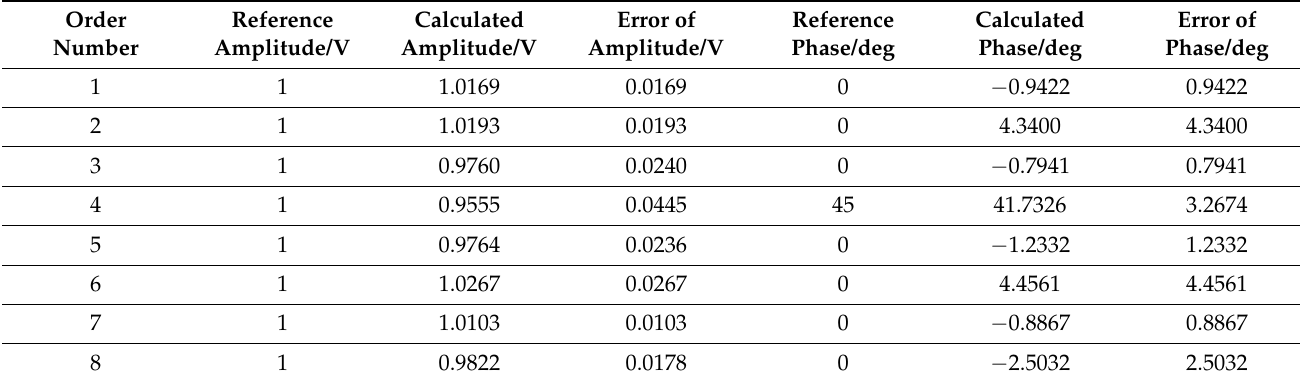
Figure 10. S parameter of Vivaldi linear array. In the event that the phase shifter of unit 4 of the phased array antenna fails. Set the feed of unit 4 as amplitude 1 V, phase 45 deg, and other units are excited with amplitude 1 V and phase 0 deg. The calculation results are shown in Table 1. Table 1. The initial feed and the calculated feed amplitude and